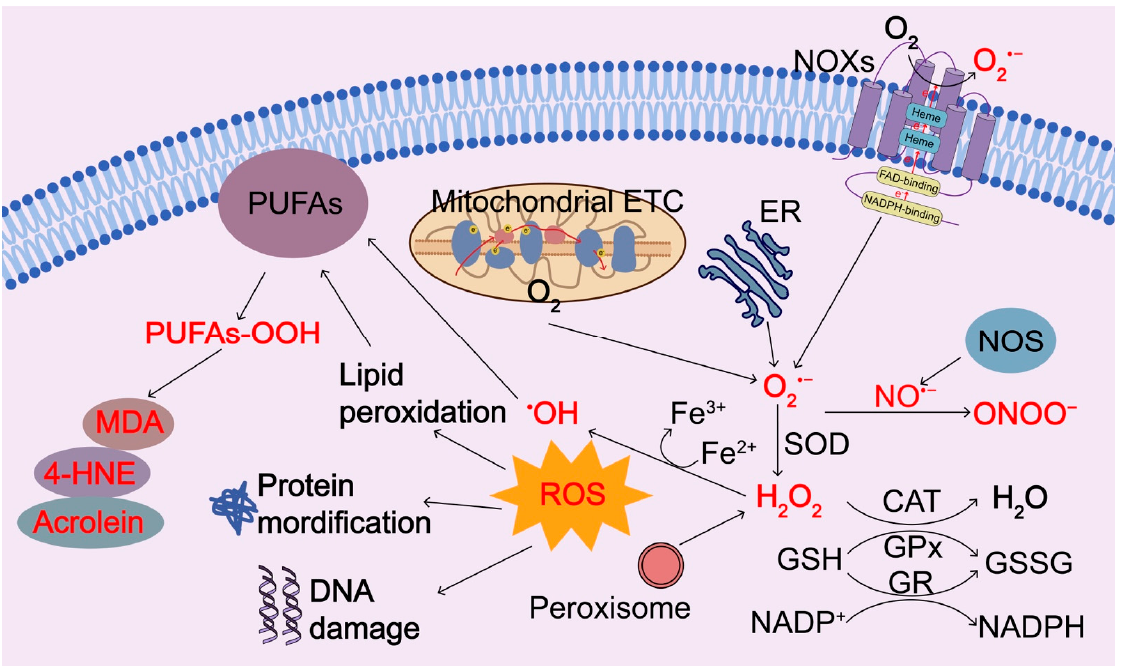
Figure 2. Regulation of ROS generation and clearance. Intracellular ROS are primarily produced by electron leak from aerobic respiration in mitochondria, oxidation of NADPH by NADPH oxidase enzymes (NOXs), oxidation processes in the endoplasmic reticulum (ER), and peroxisomes during normal O 2 metabolism. Superoxide (O 2 − ) is rapidly converted into hydrogen peroxide (H 2 O 2 ) by compartment-specific superoxide dismutases (SODs). H 2 O 2 is capable of oxidizing cysteine residues on proteins to initiate redox biology. H 2 O 2 may be converted to H 2 O by cellular antioxidant proteins, such as glutathione peroxidase (GPx) and catalase (CAT) with the concomitant conversion of glutathione to oxidized glutathione, which is then reduced by glutathione reductase (GR) at the expense of NADPH. When H 2 O 2 levels increase uncontrollably, hydroxyl radicals (OH · ) form via reactions with ferrous ions (Fe 2+ ) and irreversibly damage cellular macromolecules. Nitric oxide synthase (NOS) can induce the production of nitric oxide ( • NO), which interacts with O2 •− and forms ONOO − . ROS or oxidants can modify intracellular macromolecules, such as proteins, lipids, and DNA to initiate redox biology and damage the functions of these macromolecules. In particular, ROS can induce peroxidation of polyunsaturated fatty acids (PUFAs), resulting in the products of peroxidized lipids and their breakdown products 4-hydroxy-2-nonenal (4-HNE), malondialdehyde (MDA), and acrolein. 4-HNE, 4-hydroxy-2-nonenal; MDA, malondialdehyde; SOD, superoxide dismutase; GPx, glutathione peroxidase; CAT, catalase; NOXs, NADPH oxidase enzymes; ER, endoplasmic reticulum; GR, glutathione reductase; ETC, electron transport